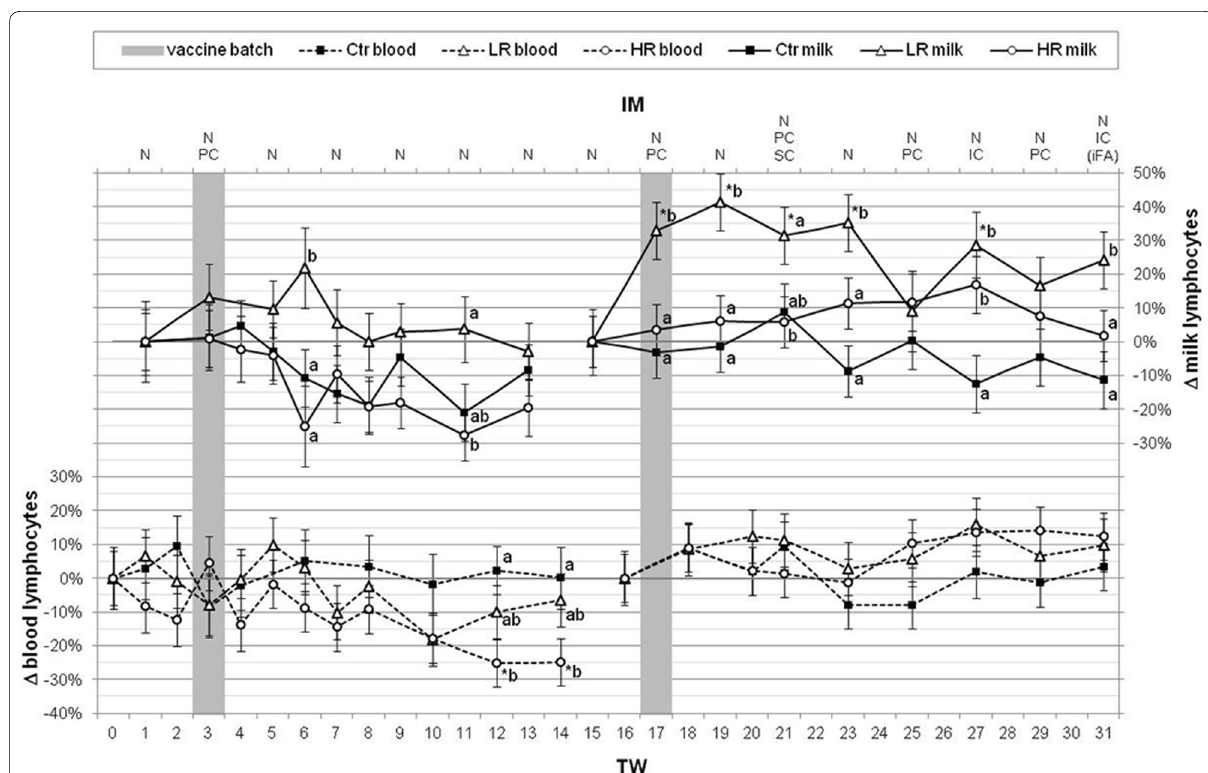
Fig. 3 Relative changes of lymphocytes out of milk and blood related to the used MucoCD - I vaccine batches. The percentage variations of lymphocyte contents per group [(“Ctr” control animals (n 5), “LR” treated, low responder animals (n 4), “HR” treated, high responder animals = = (n 5)] and per milk and blood are represented as LSM SD on the vertical axes. The comparative indices are the treatment weeks (TW) before the = ± first-time application of the vaccine batches A or B, respectively. The upper abscissa shows the used routes for administration of the vaccine [nasal (N), percutaneous (PC), subcutaneous (SC) and intracutaneous (IC)] marking the dates of immunization (IM), too. The MucoCD - I was given only once plus incomplete Freund’s adjuvant (iFA) in TW 31. In TWs 3 and TW 17, the primal injections of the vaccine batches A or B are accented by the gray bars. Deviated by group, the asterisks ( p < 0.05) indicate considerable differences relating to the dates immediately before the first use of each vaccine batch. The significant variations ( p < 0.05) between the groups at the same times are characterized by small letters (a, b,